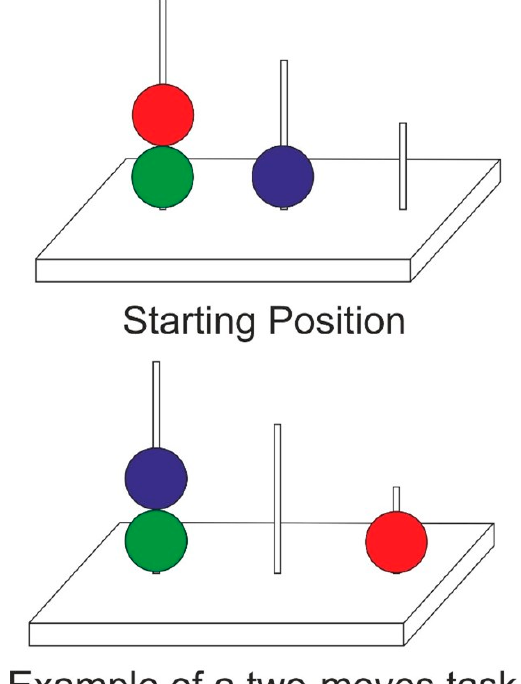
Figure 1. An example of a TOL task with a starting configuration and a simple target configuration to be reached with two moves.